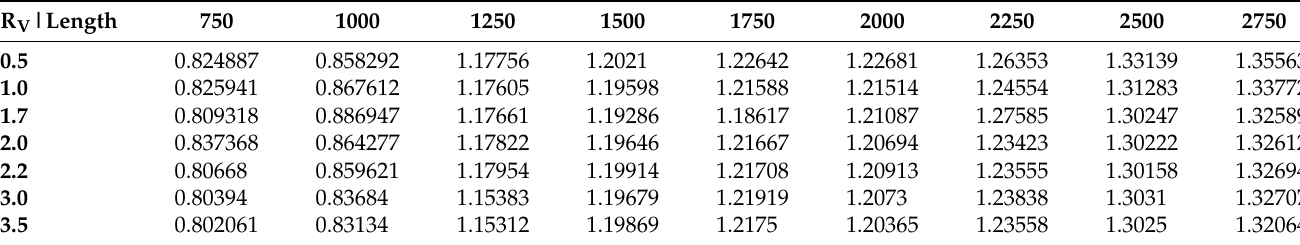
Table A15. Execution times in milliseconds on GPU with ring structure for 20,000 time-steps (1.0 s); R V on the Left and number of cells (length) on the Top .